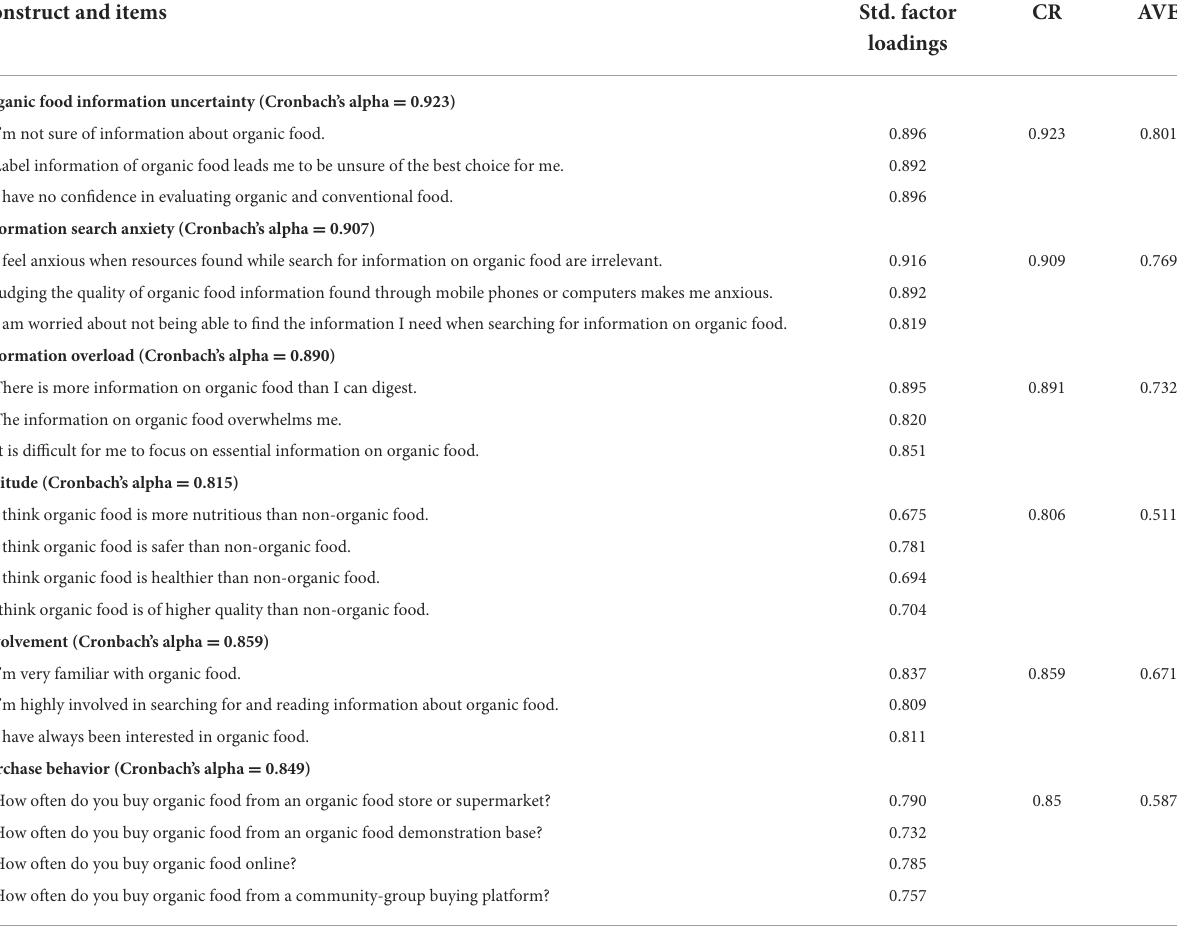
TABLE 2 Confirmatory factor analysis properties. Construct and items